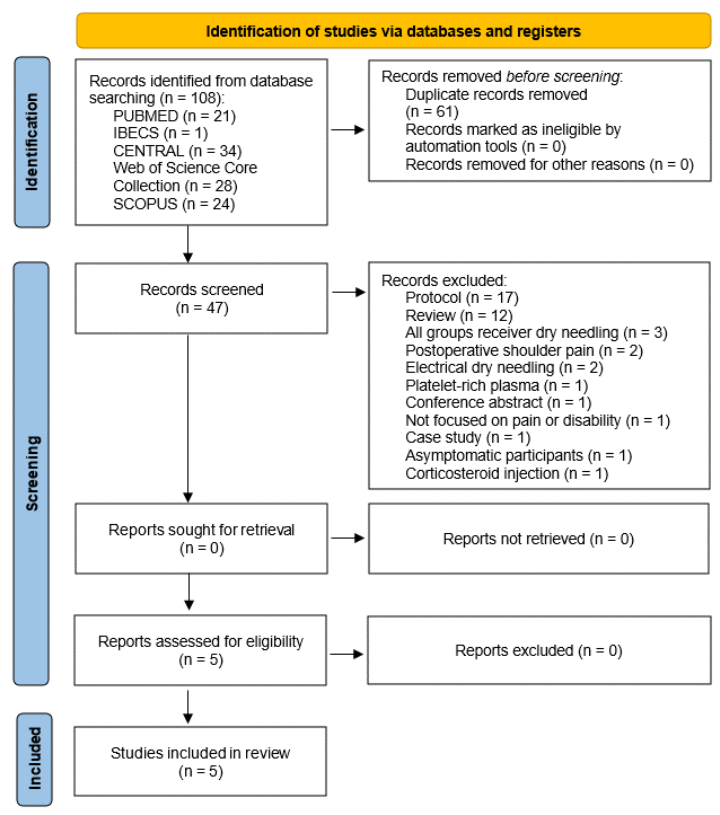
Figure 1. Flowchart of the study selection process.